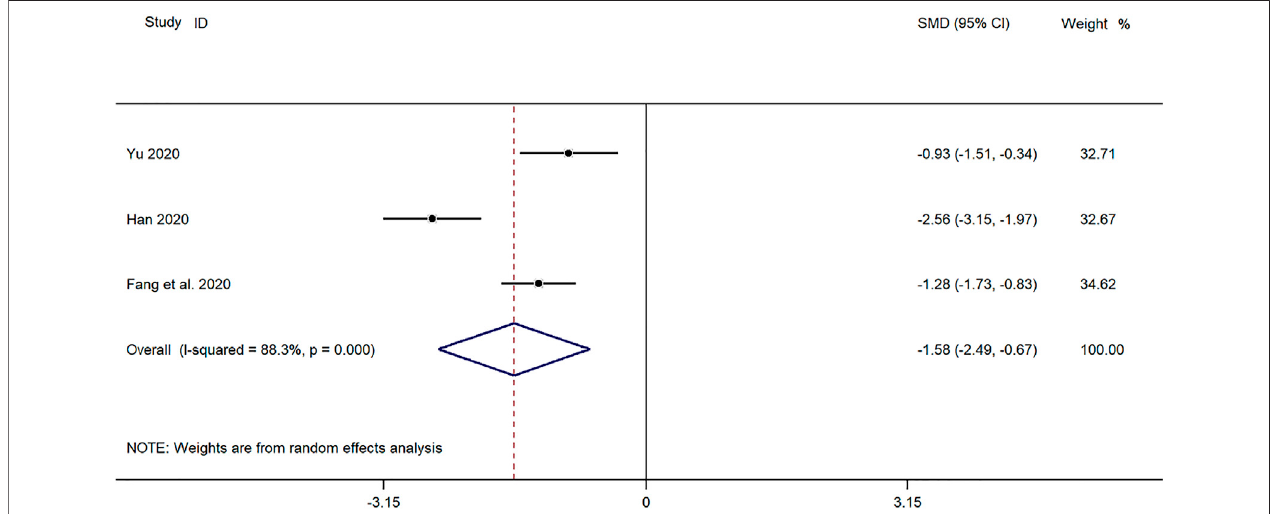
FIGURE 8 | Meta-analysis forest plot comparing the time for defervescence in the experimental and control group.